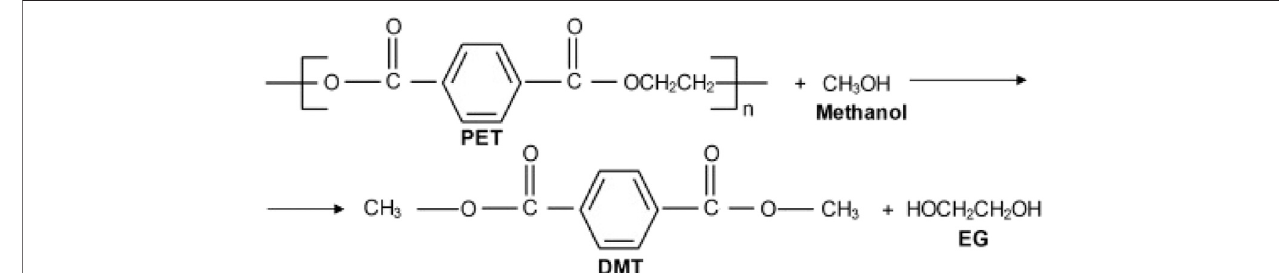
Frontiers in Environmental Science |